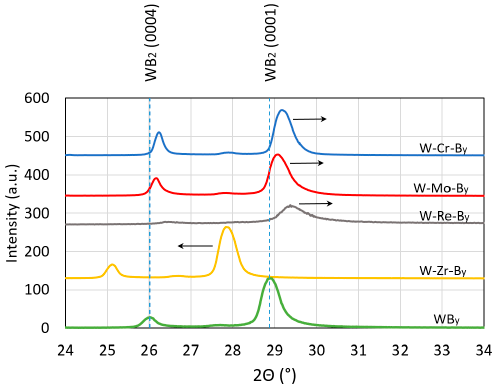
Figure 8. XRD spectra of phase composition of WB y [18] and W-TM-B y coatings deposited from targets alloyed with 24 at.% TM (TM = Cr, Mo, Re, Zr). Black arrows denote direction of shift of (0 0 0 1) peak position.